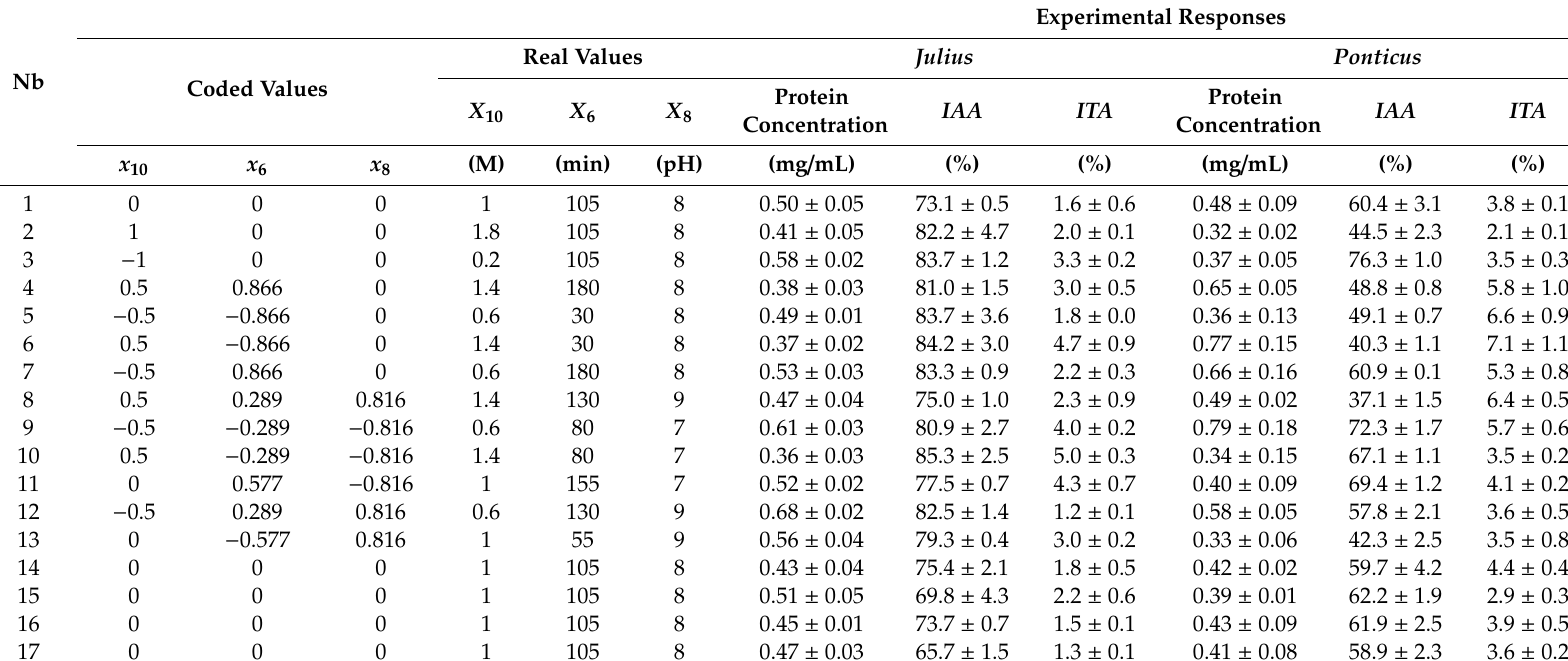
Table 2. Doehlert design and experimental responses for optimization of ATIs